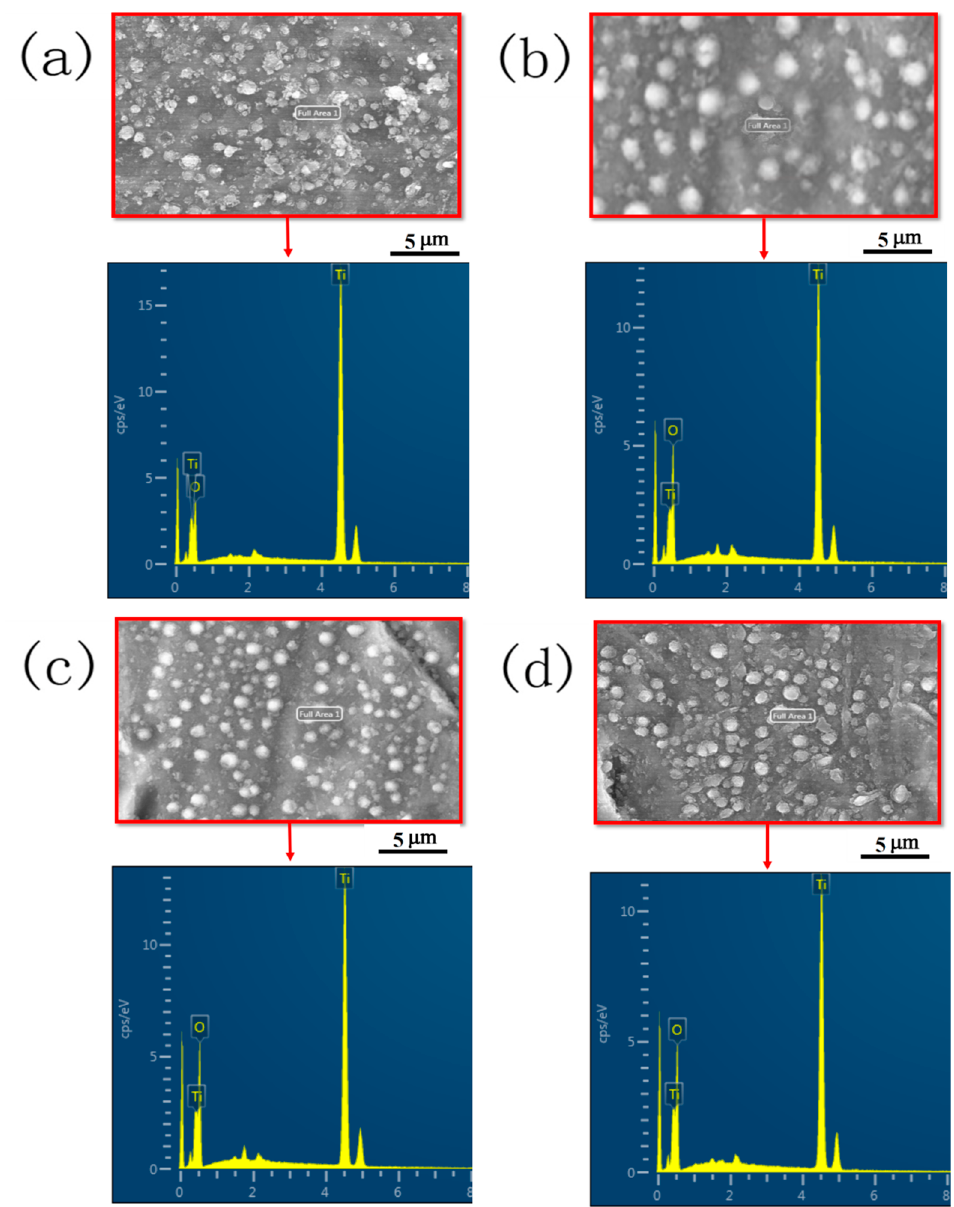
Figure 2. EDS mapping of groups ( a ) X, ( b ) Y 1 , ( c ) Y 2 and ( d ) Y 3 .